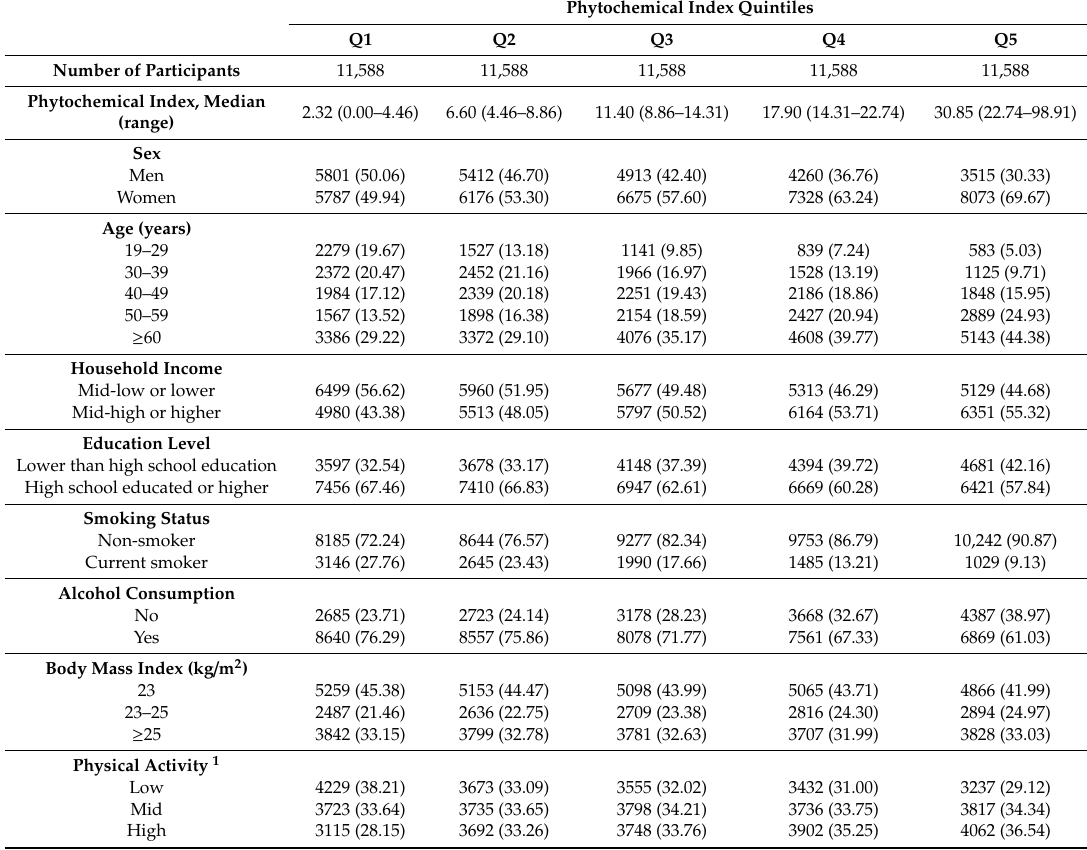
Table 1. General participant characteristics according to the phytochemical index quintile, KNHANES 2008–2018 (n =